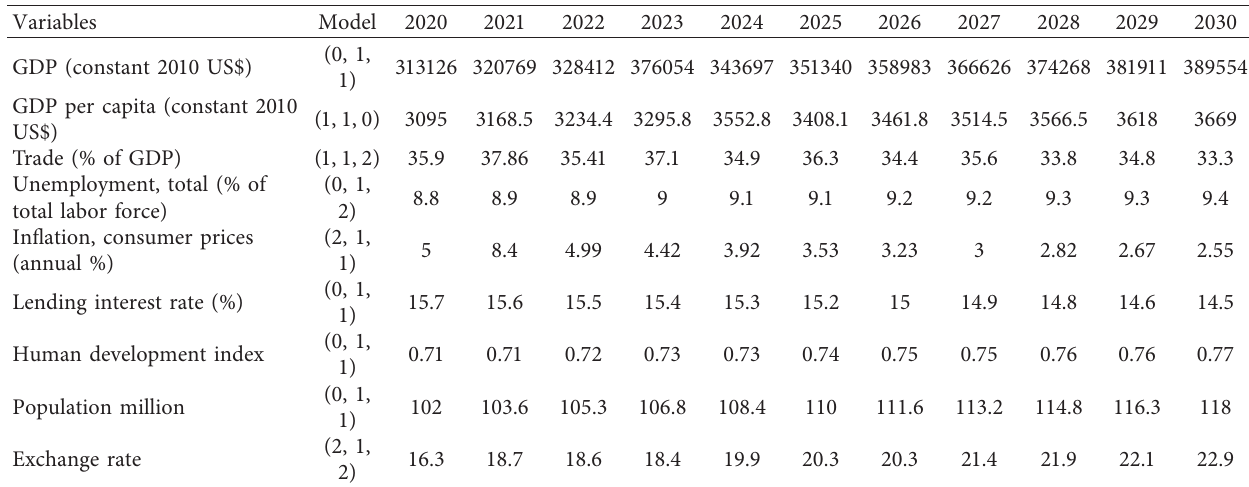
Figure 1: A gradient boosting prediction for the actual FDI Table 3: Independent variables’ prediction by the ARIMA model.